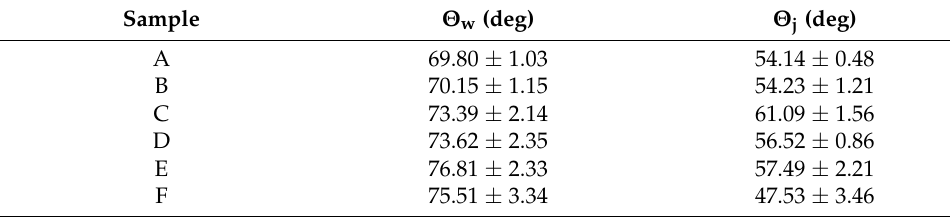
Table 3. Contact angles of sample surfaces with water and diiodomethane.